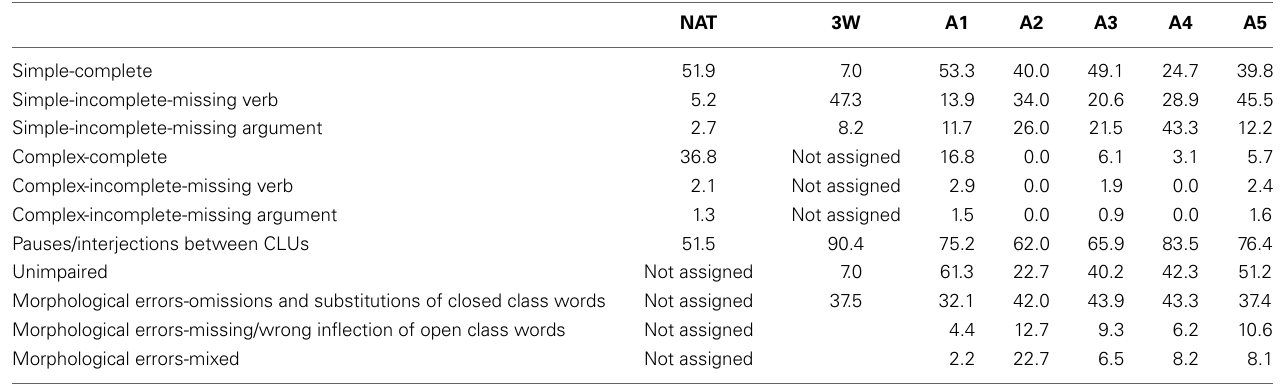
Table 4 | Occurrence of the assigned categories related to the total number of CLUs in